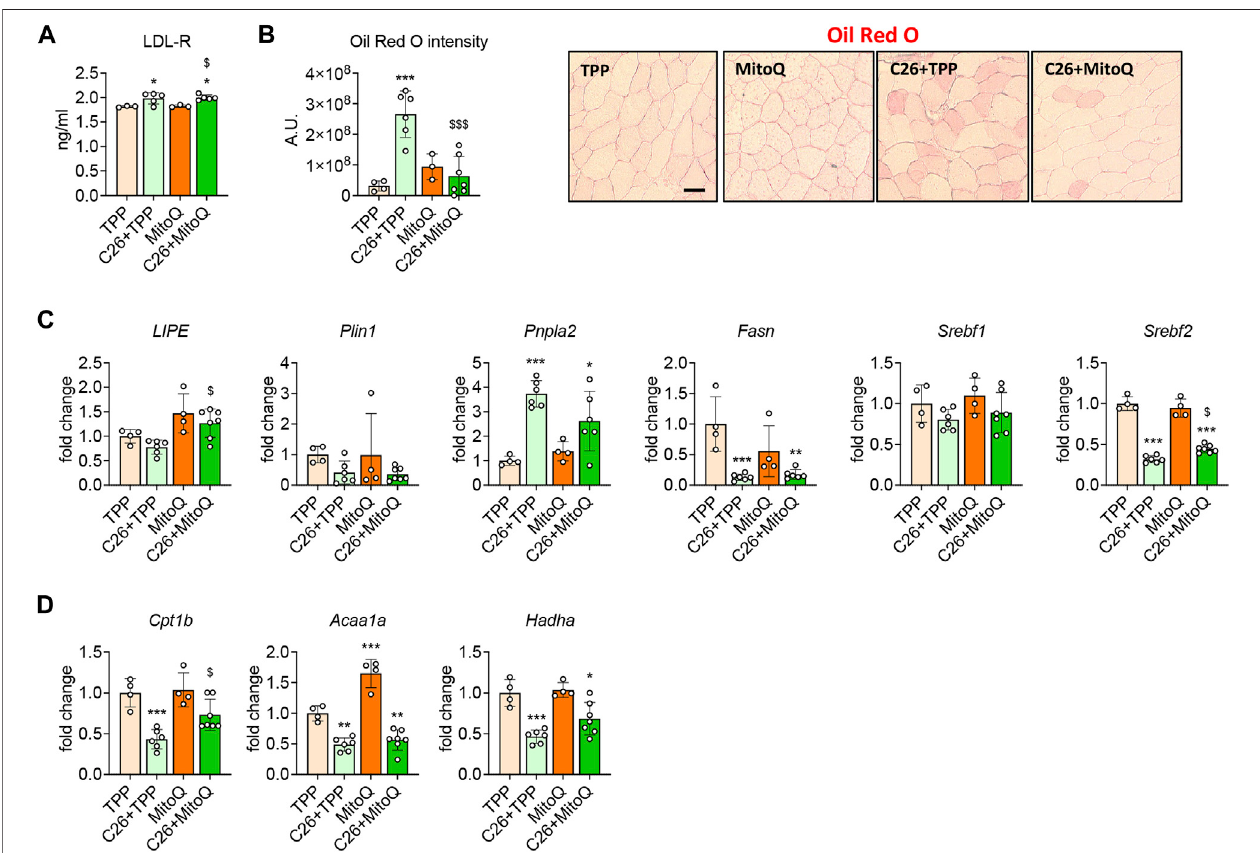
FIGURE 5 | MitoQ treatment reduces myosteatosis and improves β -oxidation. (A) Quanti fi cation of LDL-R levels in gastrocnemius muscle. (B) Oil Red O staining and quanti fi cation of tibialis anterior muscle. Scale bar, 100 μ m. (C) Gene expression levels for markers of lipolysis and lipogenesis such as Lipe, Plin1, Pnpla2, Fasn, Srebf1 and Srebf2 inthegastrocnemiusmuscle. (D) Geneexpression levelsformarkersof β -oxidation suchas Cpt1b, Acaa1a and Hadha inthegastrocnemiusmuscle. Gene expression was normalized to TBP levels and expressed as fold change vs. TPP. Data are expressed as means ± SD. Statistical signi fi cance was evaluated bytwo-wayanalysisofvariance,andsigni fi cantdifferences(atleast p < 0.05)werereportedas:* p < 0.5** p < 0.01,*** p < 0.001 vs. TPP; $ p < 0.05, $$$ p < 0.001 vs. C26 +